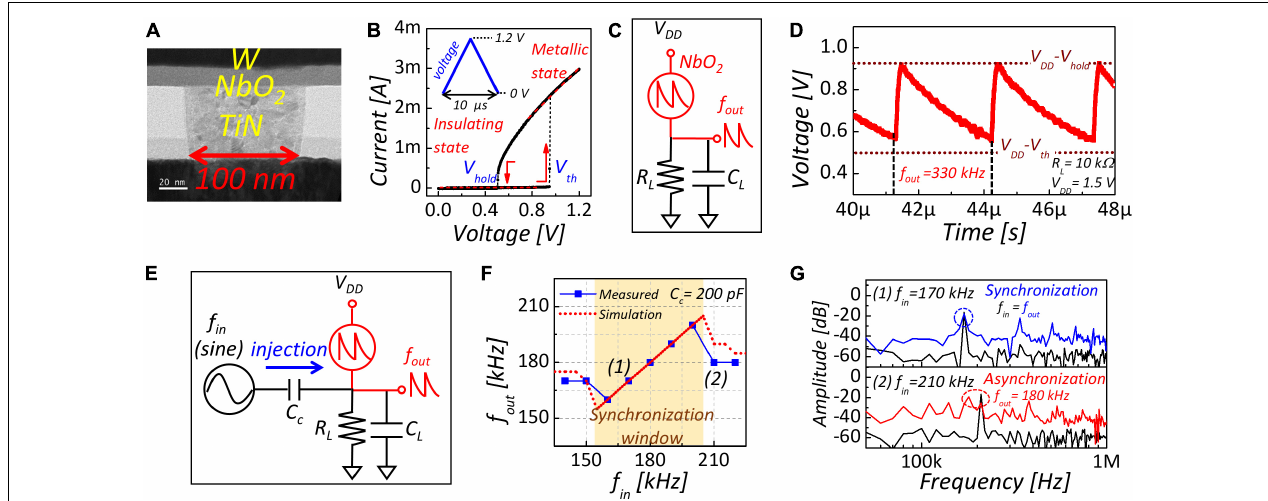
FIGURE 1 | (A) TEM image of NbO 2 -based IMT device. (B) I–V characteristic of the NbO 2 -based IMT device. (C) Schematic diagram of NbO 2 -based oscillator. (D) Output waveform of NbO 2 -based oscillator when load resistor is 10 k (cid:127) . (E) Schematic diagram of injection locking with input signal. (F) Output frequency as a function of input frequency. Colored region is synchronization window. (G) Fast Fourier transformation (FFT) result of input and output frequency. In FFT analysis, sampling rate is 400 Ms − 1